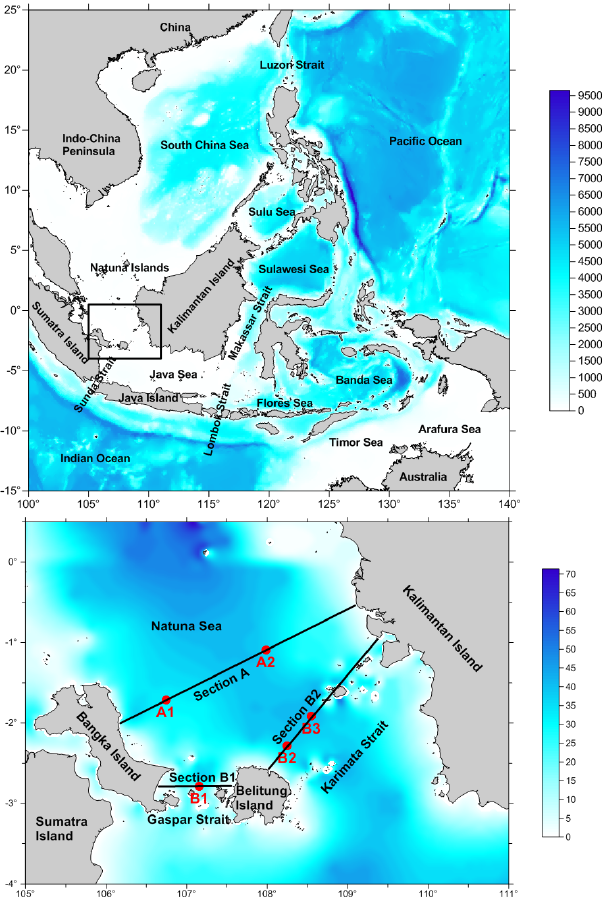
Figure 1. The map of the Indonesian seas (upper) and observational stations (lower). Isobaths are in